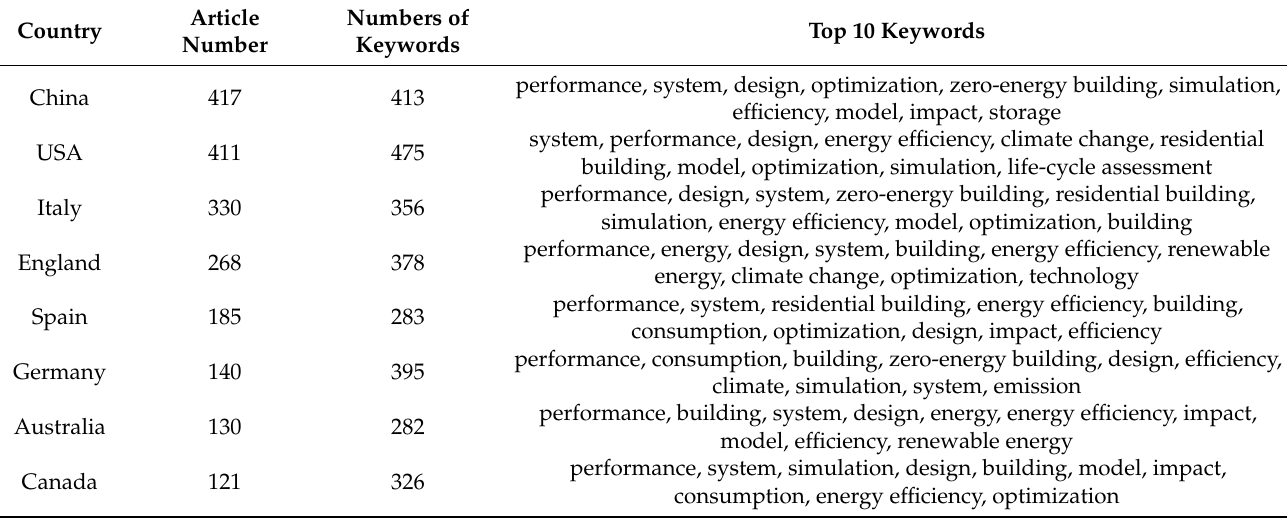
Table 4. Keyword analysis of the 8 key